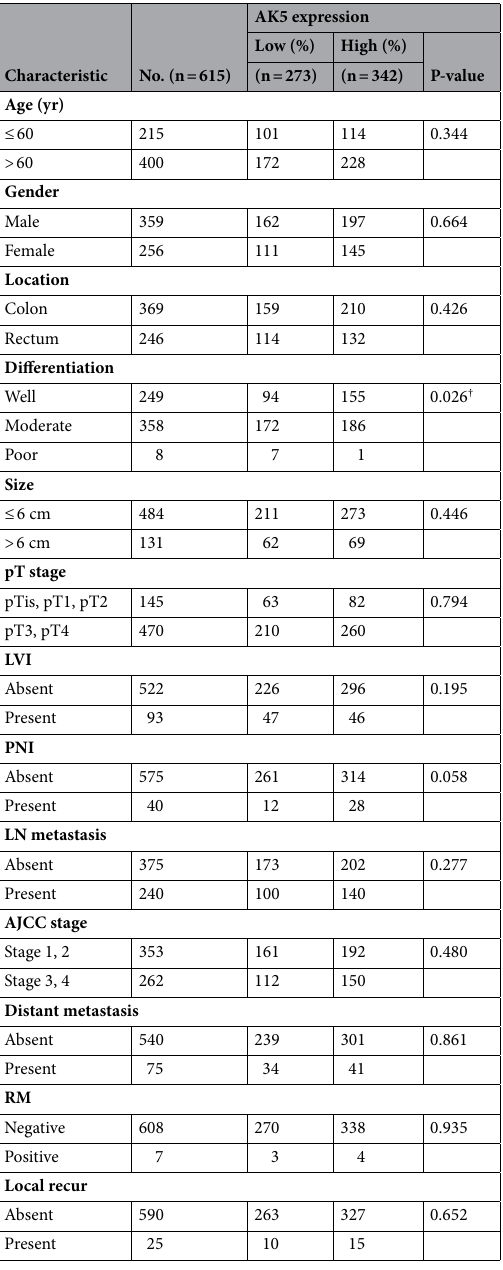
Table 1. Association between the AK5 expression and clinicopathologic factors. AJCC American Joint Committee on Cancer, LVI lymphovascular invasion, PNI perineural invasion, LN lymph node, RM resection margin. † P - values < 0.05 were considered statistically